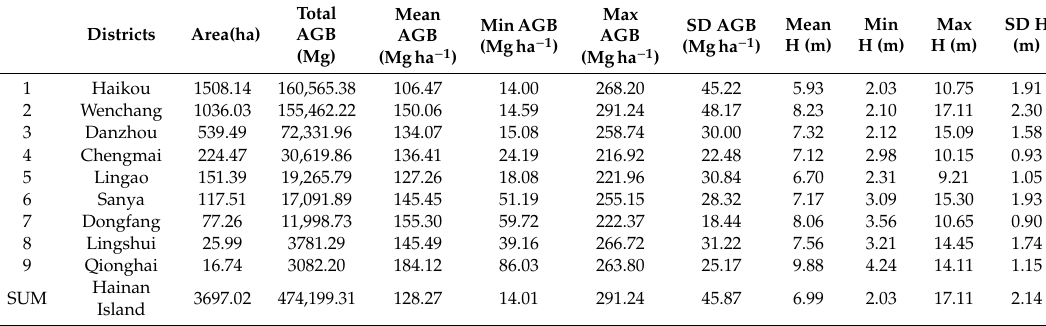
Table 5. Summaries of the mangrove AGB and height (H) in di ff erent districts of Hainan